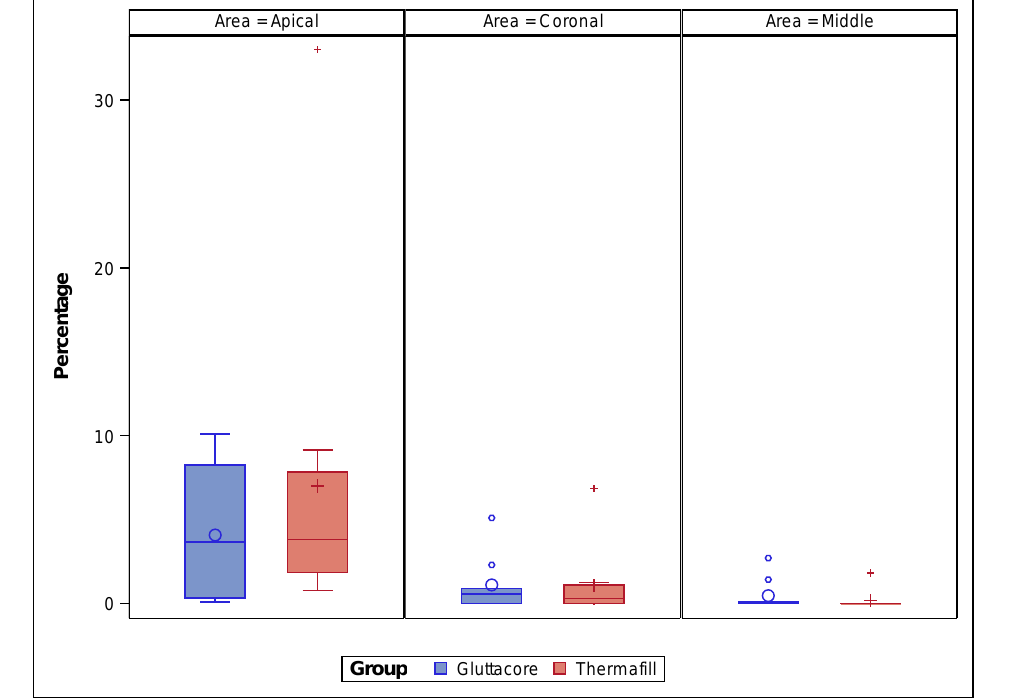
Table 5. Descriptive analysis of the time (min) used to remove the root canal filling materials in- side the root canal systems.